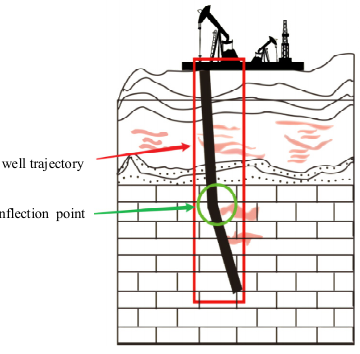
Figure 1. A schematic diagram of the well